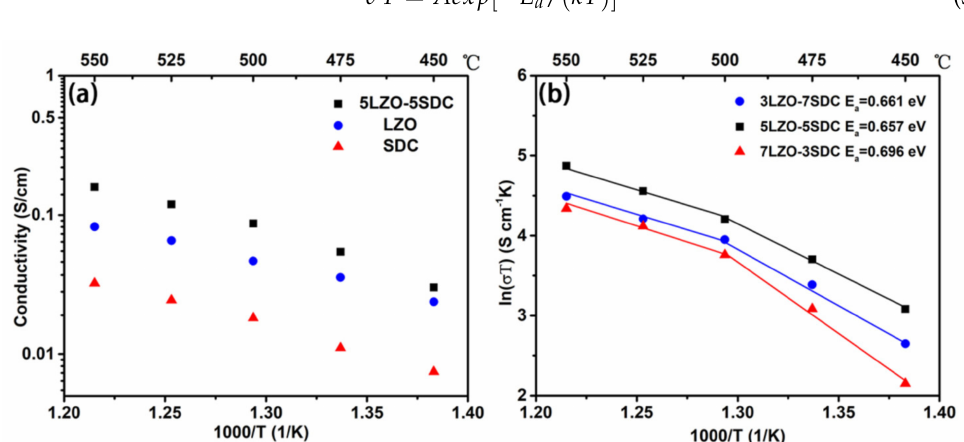
Figure 5. ( a ) Ionic conductivity plot of LZO and 5LZO-5SDC composites as a function of 1000/T obtained from I–V polarization curves at 450–550 ◦ C for comparison with reported SDC; ( b ) activation energy ( E a ) plots of LZO-SDC composites as a function of 1000/T with E a values in the range of 500–550 ◦